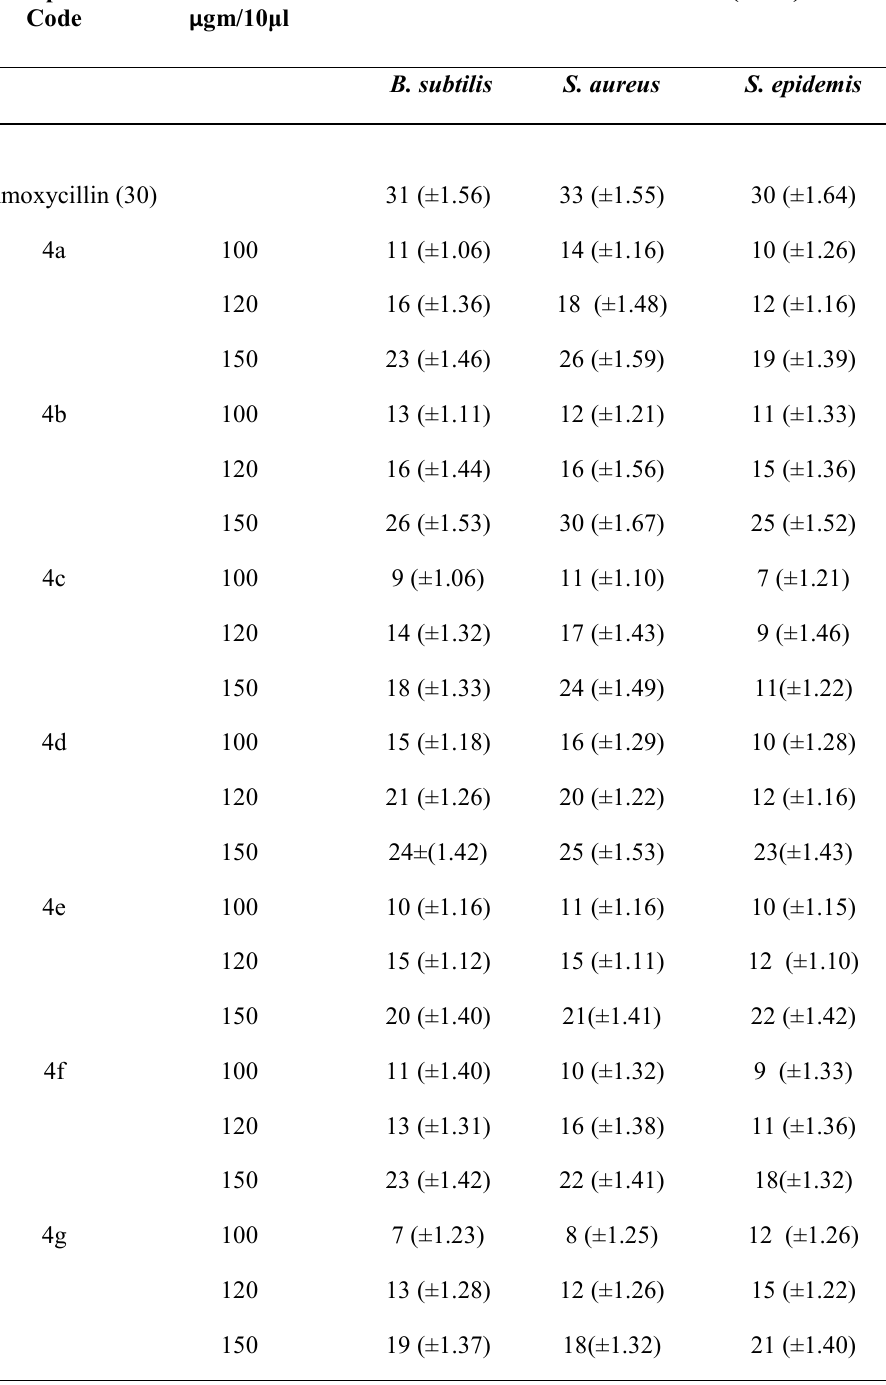
Table III: Zone of inhibition of synthesized compounds against gram negative bacteria.